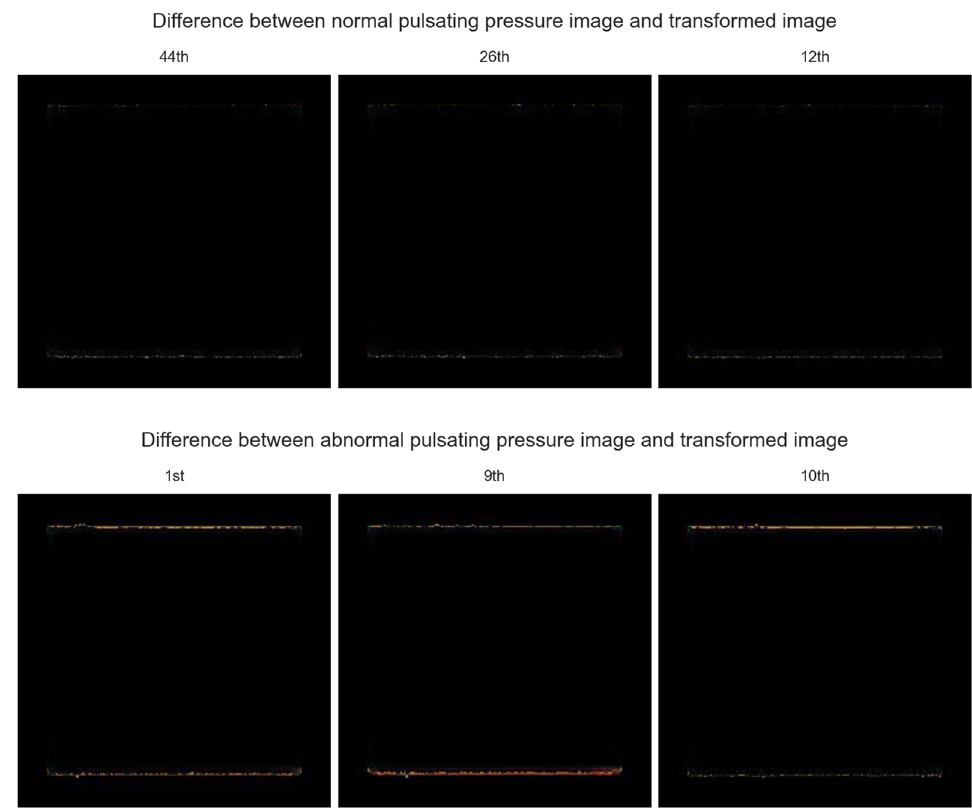
Figure 11. Difference between pulsating pressure images and transformed images. Table 4. Minimum, average, and maximum values of the differences between pulsating pressure images and transformed